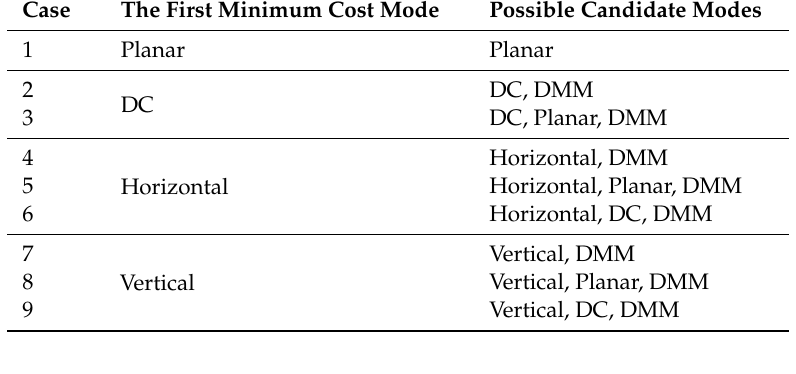
Table 2. Possible candidate modes in the RD list based on the mode pattern table.